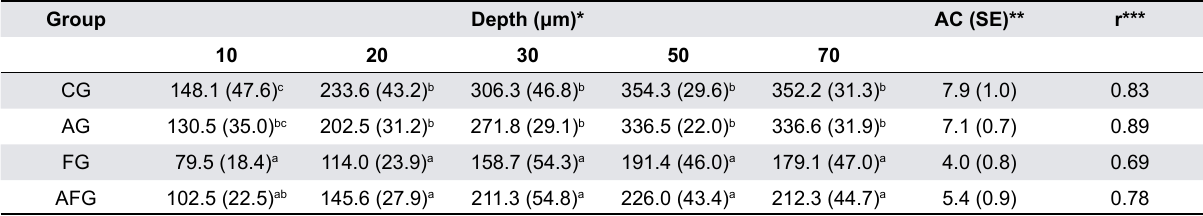
enamel. In the gray scale image, the black area corresponds to the original orange bands and the white area corresponds to the original white bands. For each segmented area, the method computes the average of the pixel intensities in the input image Figure 1- Schematic diagram of DFIA index for quantification of fluorosis Table 2- Mean (SD) of Knoop hardness (KHN). Estimates of angular coefficient (AC) and of standard error (SE): AC(SE) and correlation coefficient (r) Group